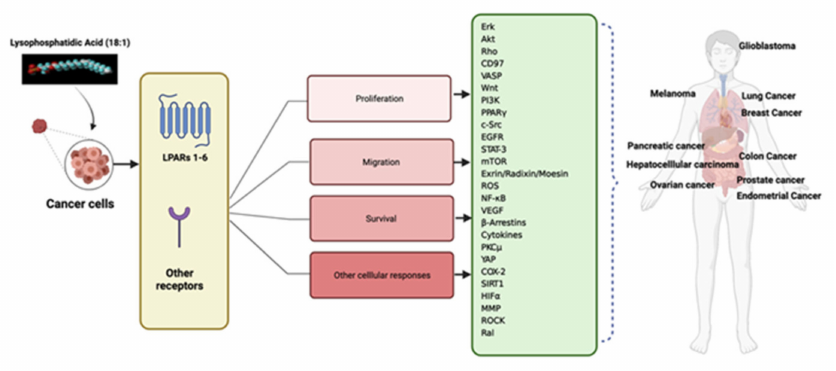
Figure 2. Lysophosphatidic acid responses in human cancers. LPA binds to LPARs 1–6 as well as to other non-GPCR receptors. These receptors can mediate the proliferation, migration, and survival of cancer cells as well as other tumor phenomena such as angiogenesis and progression. The green box lists signal transduction events, discussed in this review, that occur downstream of LPAR activation. These signals contribute to the cancers that are shown in the human figure and are specifically discussed in this review. This figure was made using www.biorender.com; Accessed on 4 August